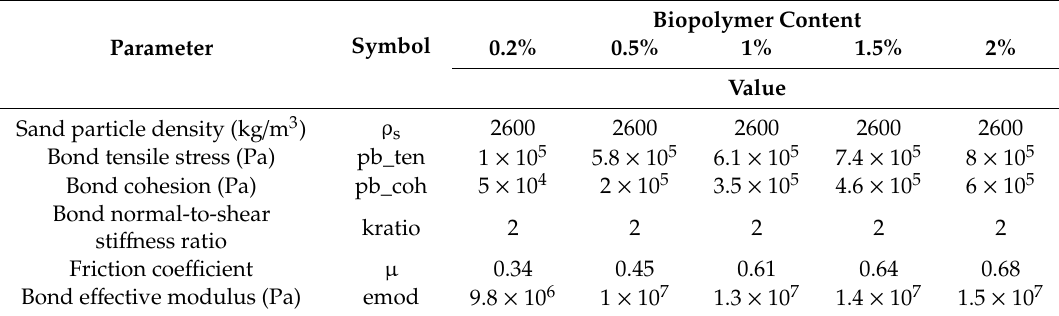
Table 1. Bond parameters of contact